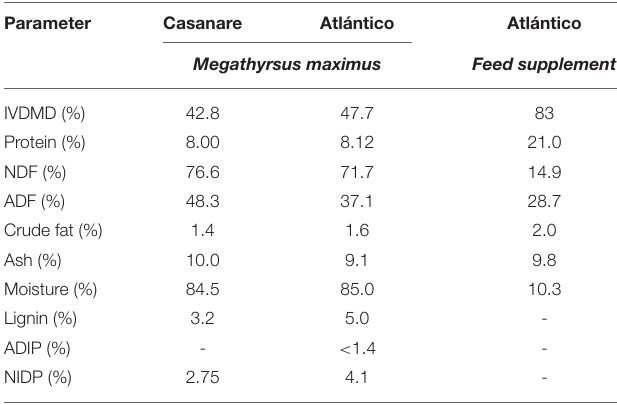
TABLE 1 | Chemical composition of pastures and feed supplements collected in Casanare and Atlántico localities. Parameter